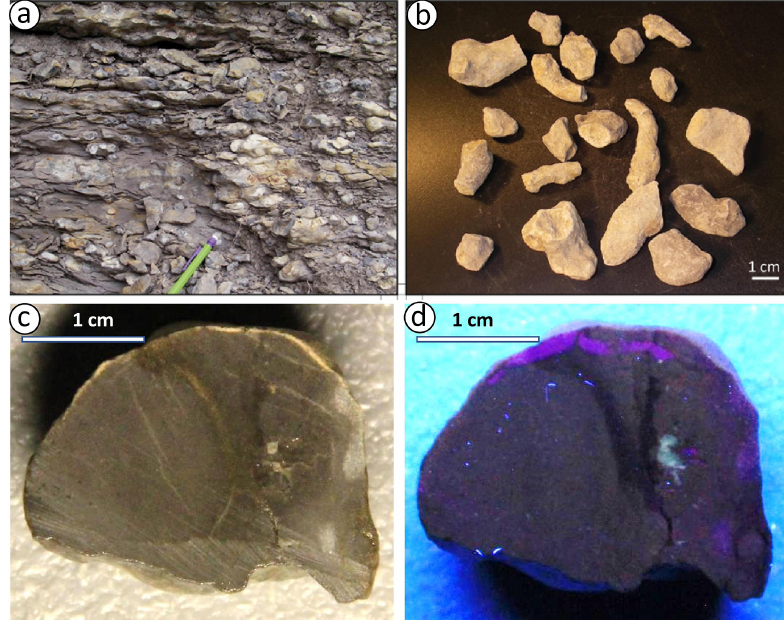
Figure 5. Facies 2 (F2): nodular marl. (a) Outcrop view. (b) Individual nodules and nodule clusters. (c, d) Cross section of a nodule under natural (c) and UV light (d) ; the vertical parting in the middle of the sample that shows a darker color in (c) but is non-fluorescent in (d) is suggestive of previous boundary between two, now clustered